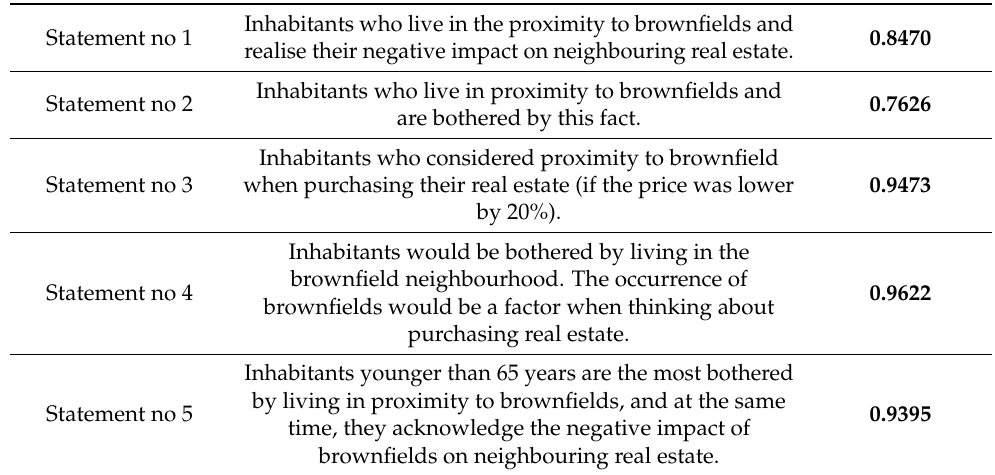
Table 3. Pearson correlation coefficient values calculated for the statements in the